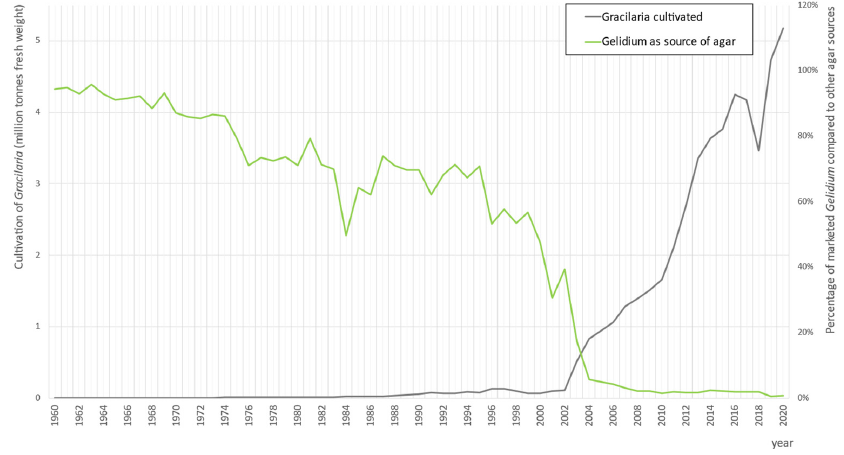
Figure 5. Percentage use of Gelidium as agar-bearing biomass source (green line) compared to the cultivation of Gracilaria (grey line), between 1960 and 2020. Data from FAO [44]. The Gelidium agar market, hence, has severely declined from over 92% in 1967, with